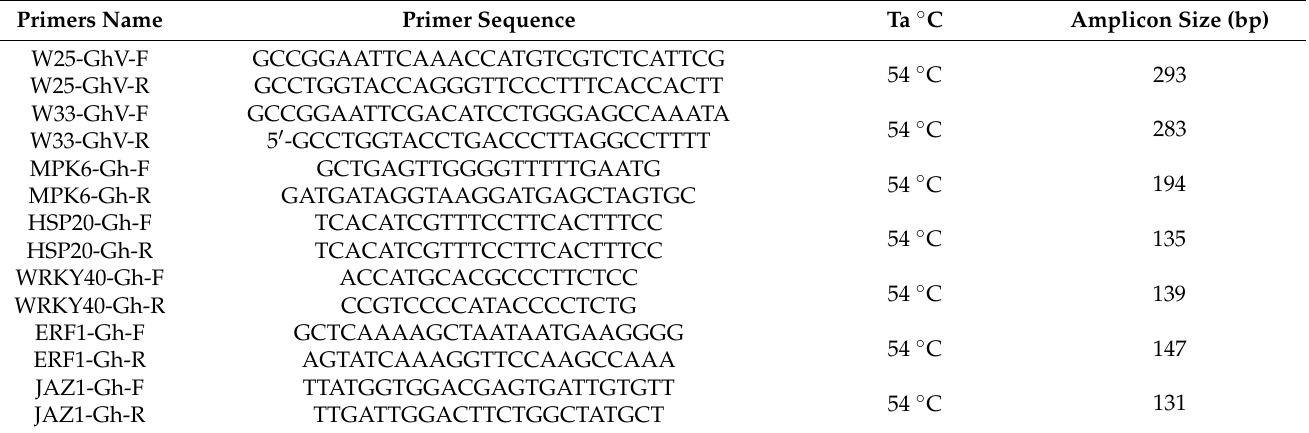
Table 1. Primer sequences used for the amplification of the targeted